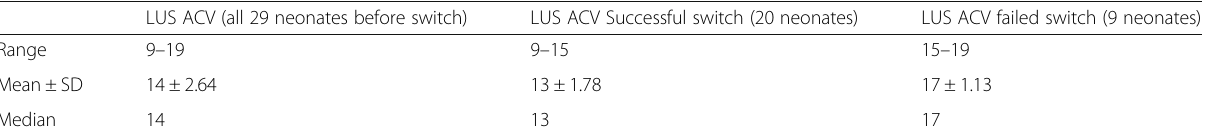
Table 2 Showing LUS scores for neonates on AC ventilation before switching to SIMV and the difference in scores between patients with successful and failed switch LUS ACV (all 29 neonates before switch)